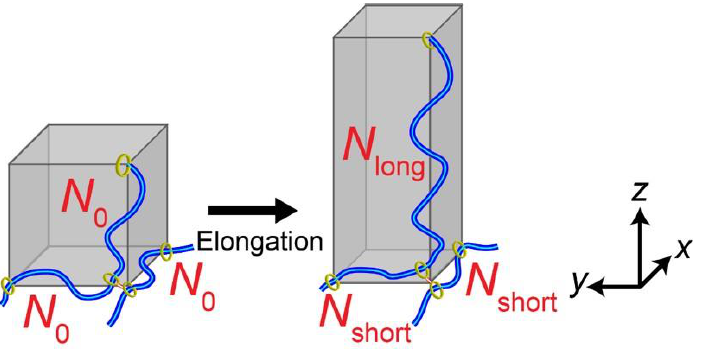
Figure 8. Schematic illustration of 3-chain model for SR gels. Reprinted from [27] with permission from American Chemical Society.